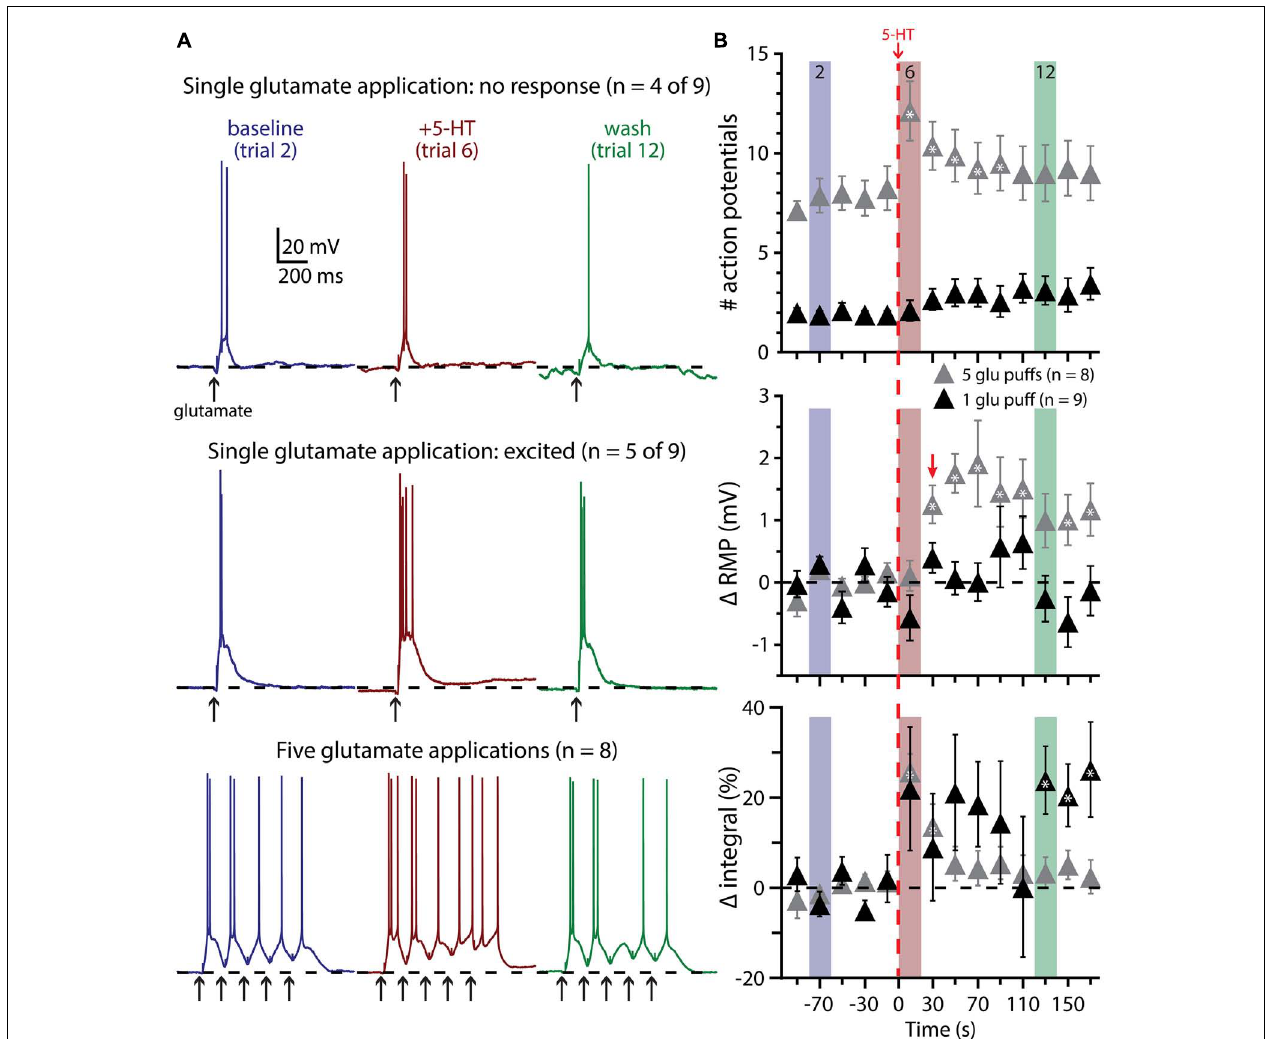
FIGURE 6 | Suprathreshold glutamatergic drive facilitates serotonergic excitation in COM-excited L5PNs. (A) Responses of COM-excited L5PNs to single glutamate applications that were not facilitated by 5-HT application (top traces; n = 4 of 9) and responses of COM-excited L5PNs to single glutamate application in neurons that were facilitated by 5-HT application (middle traces; n = 5 of 9). Blue traces at left show baseline responses to glutamate, while red traces show responses to glutamate after 5-HT application, and green traces show responses to glutamate approximately two minutes after 5-HT exposure (“wash”). Bottom traces show responses to bursts of five glutamate applications (5 Hz) in baseline conditions (blue traces), after 5-HT application (red traces), and in wash